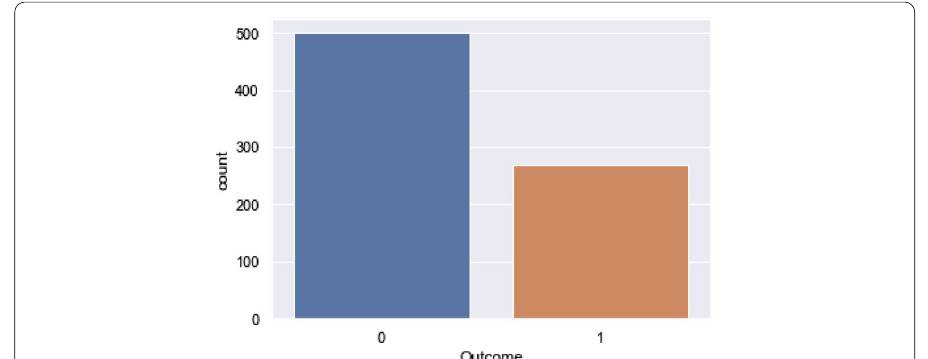
Fig. 7 Population distribution of the Dataset1 0: diabetic cases, 1: non-diabetic cases